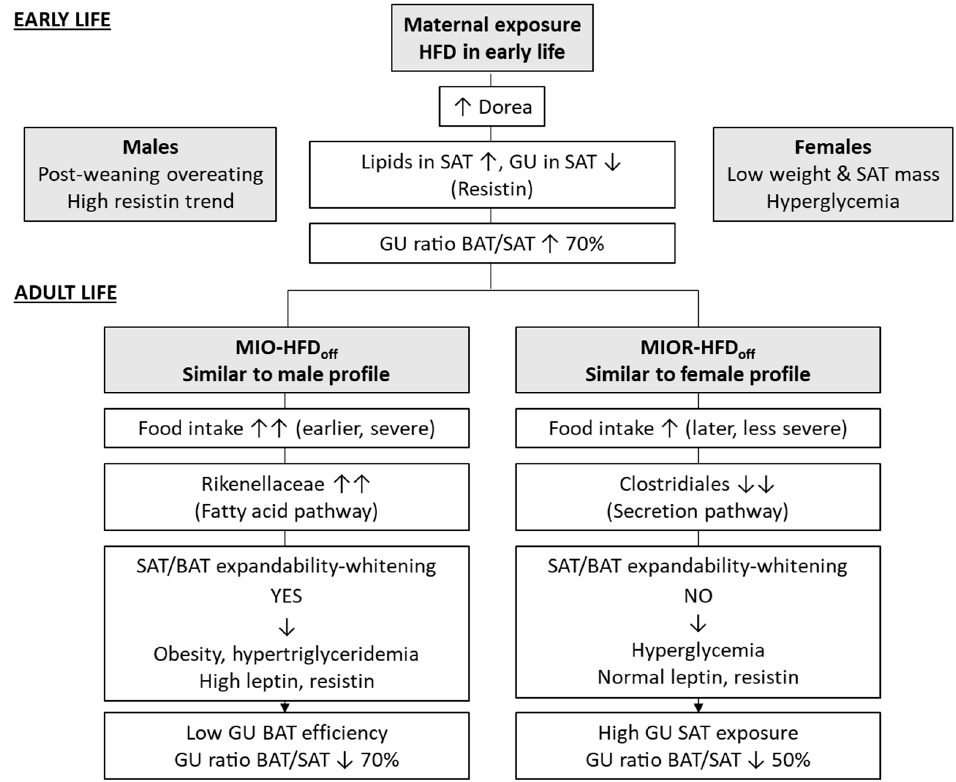
Figure 3. Diagram of features underlying the distinct phenotypes in early- and adult-life, as both induced by maternal HFD exposure during pregnancy and lactation. The top section refers to the weaning age of the offspring when obesity or hyperglycemia have not developed, though differences between sexes suggest early phenotypic seeding. The bottom section highlights distinct patterns of fat and microbiota development that relate to different complications in later life, consistent with the human situation, in which maternal obesity leads to greater odds-ratios of obesity or diabetes [8], but many offspring remain normal weight or non-diabetic. Sex was analyzed to point out that a majority of individuals developing obesity in response to maternal HFD were males and the ones developing hyperglycemia were mostly females. In humans, we know that women born to obese mothers are more prone than men to develop diabetes in later life [8]. Though obesity/diabetes proneness and sex seem to overlap largely in our results, the two analyses are conceptually independent and shown separately until mechanisms are clarified.